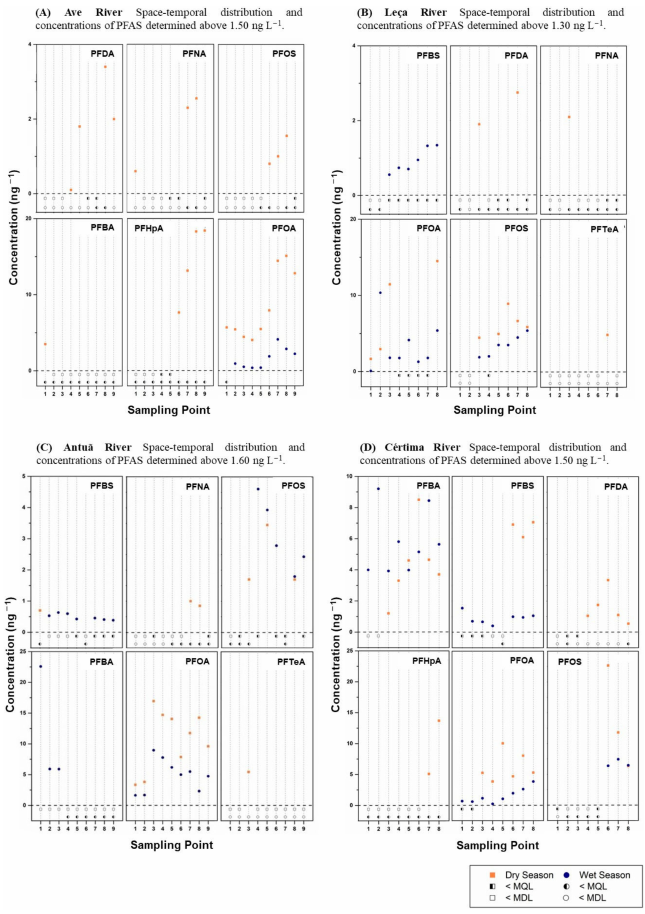
Figure 1. Space-temporal distribution of PFASs and the concentration of compounds found at higher concentrations in the four river basins: ( A ) Ave, ( B ) Leça, ( C ) Antu ã , and ( D ) C é